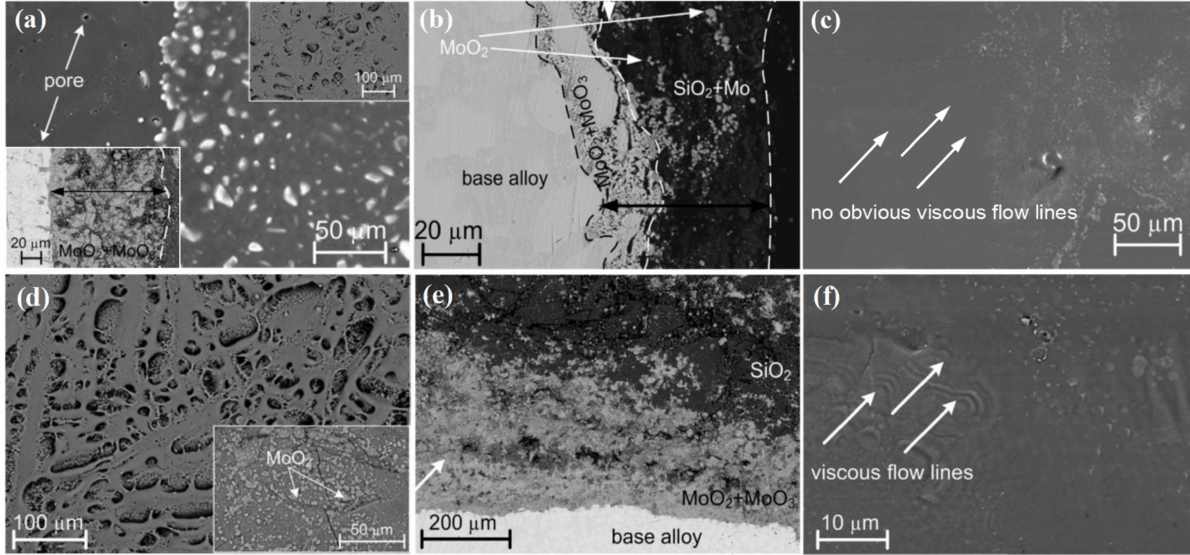
Figure 7. Surface and cross-sectional SEM (BSE) images of MSB 1 ( a – c ) and MSBCe ( d – f ) alloys oxidized at different temperatures for 24 h: 900 ◦ C ( a , d ), 1100 ◦ C ( b , e ) and 1300 ◦ C ( c , f ). Reproduced with permission [103]. Copyright 2016